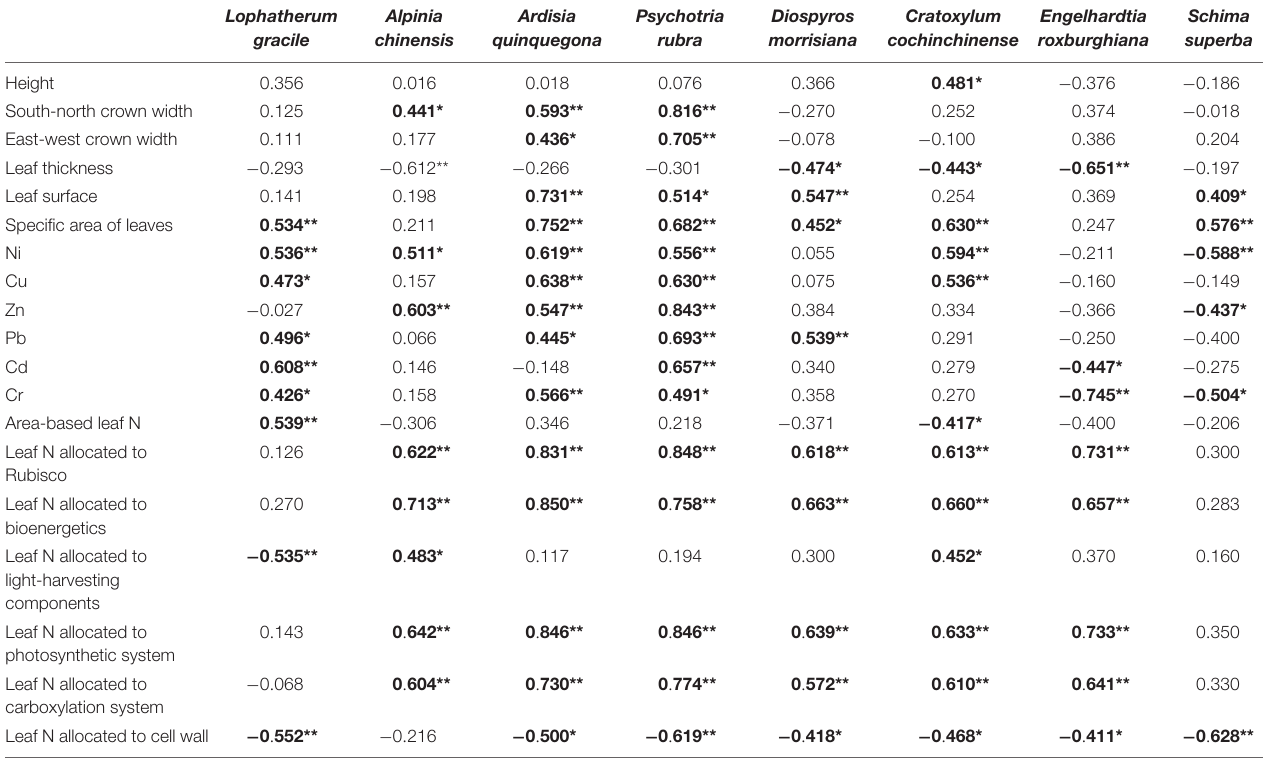
TABLE 1 | Correlation coefficients and P levels of the Pearson’s correlation among maximum photosynthetic rate and plant external size, leaf appearance, heavy metal concentration, and N allocated into different components. Lophatherum Alpinia Ardisia gracile chinensis